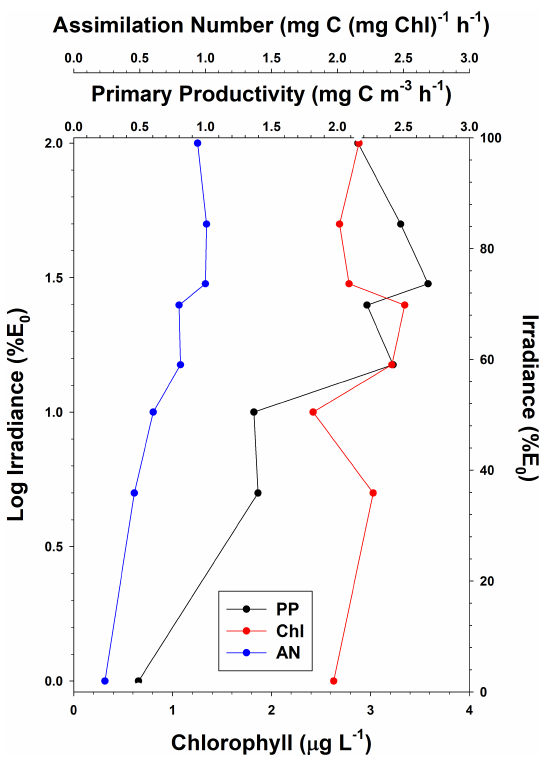
Figure 2. Vertical distribution of average primary productivity (PP), chlorophyll concentrations (Chl), and assimilation numbers (AN) in the Ross Sea. Standard deviations for all depths and all variables are listed in Table 3.